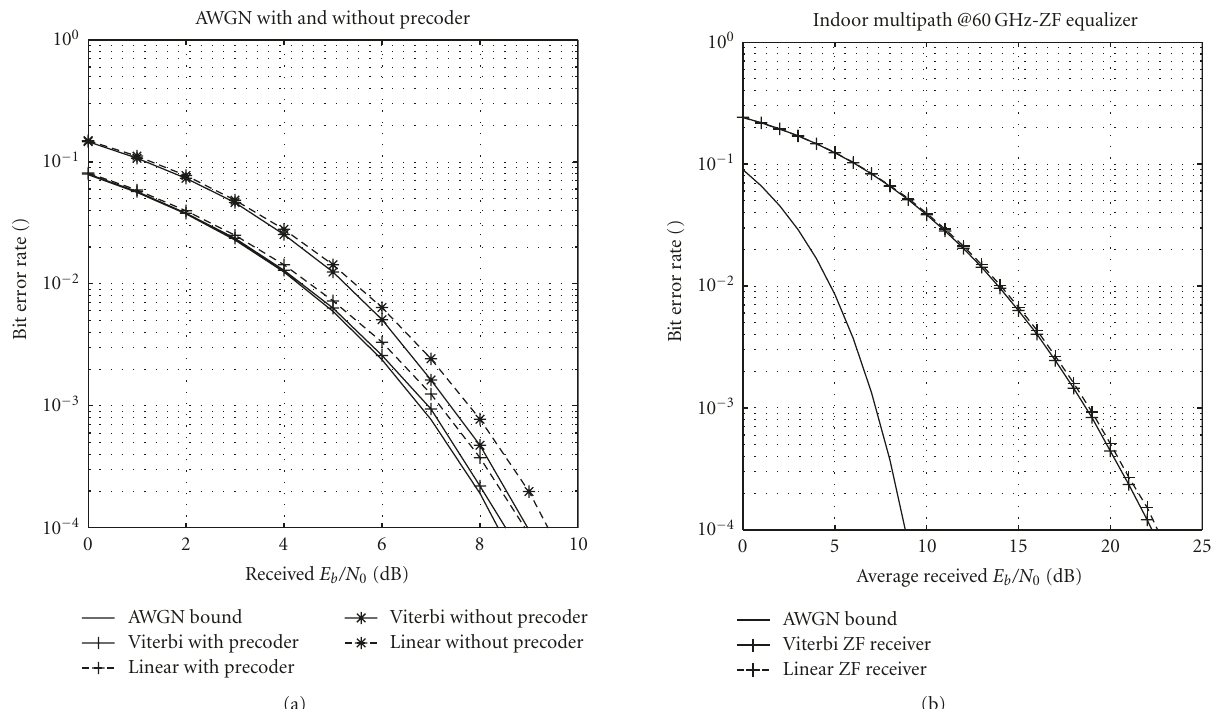
Figure 11: BER performance of CPM with ZF equalizer for di ff erent